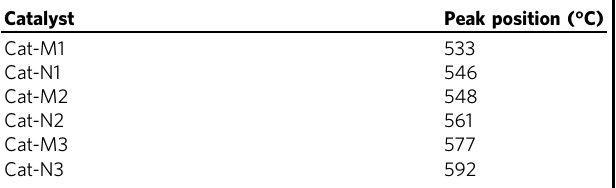
Table 4 Peak positions of formed coke in DTG curves over used catalysts with different reaction cycles under methane and nitrogen.